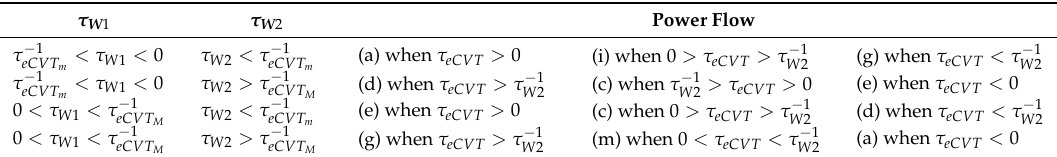
Table 11. Case 4—Power flows for each range of the planetary gear constants. τ W 1 τ W 2 Power